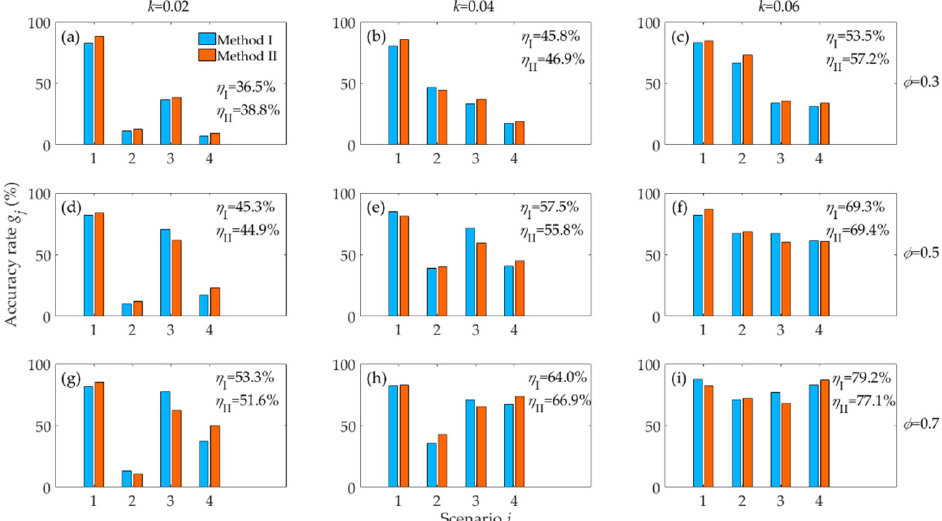
Figure 7. Accurate rates of trend tests by the MMK test and OW operation in simulation experiment 2 at the 5% significance level. (Note: the length of STS is 30; k and φ are the trend slope and the autoregressive coefficient in the simulation experiment 2; I and II represent the results of the MMK test and OW operation, respectively; sub-figure ( a ) shows the accurate rates corresponding to the case of k = 0.02 and φ = 0.3; sub-figure ( b ) displays the accurate rates corresponding to the case of k = 0.04 and φ = 0.3; sub-figure ( c ) exhibits the accurate rates corresponding to the case of k = 0.06 and φ = 0.3; sub-figure ( d ) shows the accurate rates corresponding to the case of k = 0.02 and φ = 0.5; sub-figure ( e ) shows the accurate rates corresponding to the case of k = 0.04 and φ = 0.5; sub-figure ( f ) displays the accurate rates corresponding to the case of k = 0.06 and φ = 0.5; sub-figure ( g ) displays the accurate rates corresponding to the case of k = 0.02 and φ = 0.7; sub-figure ( h ) shows the accurate rates corresponding to the case of k = 0.04 and φ = 0.7; and sub-figure ( i ) exhibits the accurate rates corresponding to the case of k = 0.06 and φ =